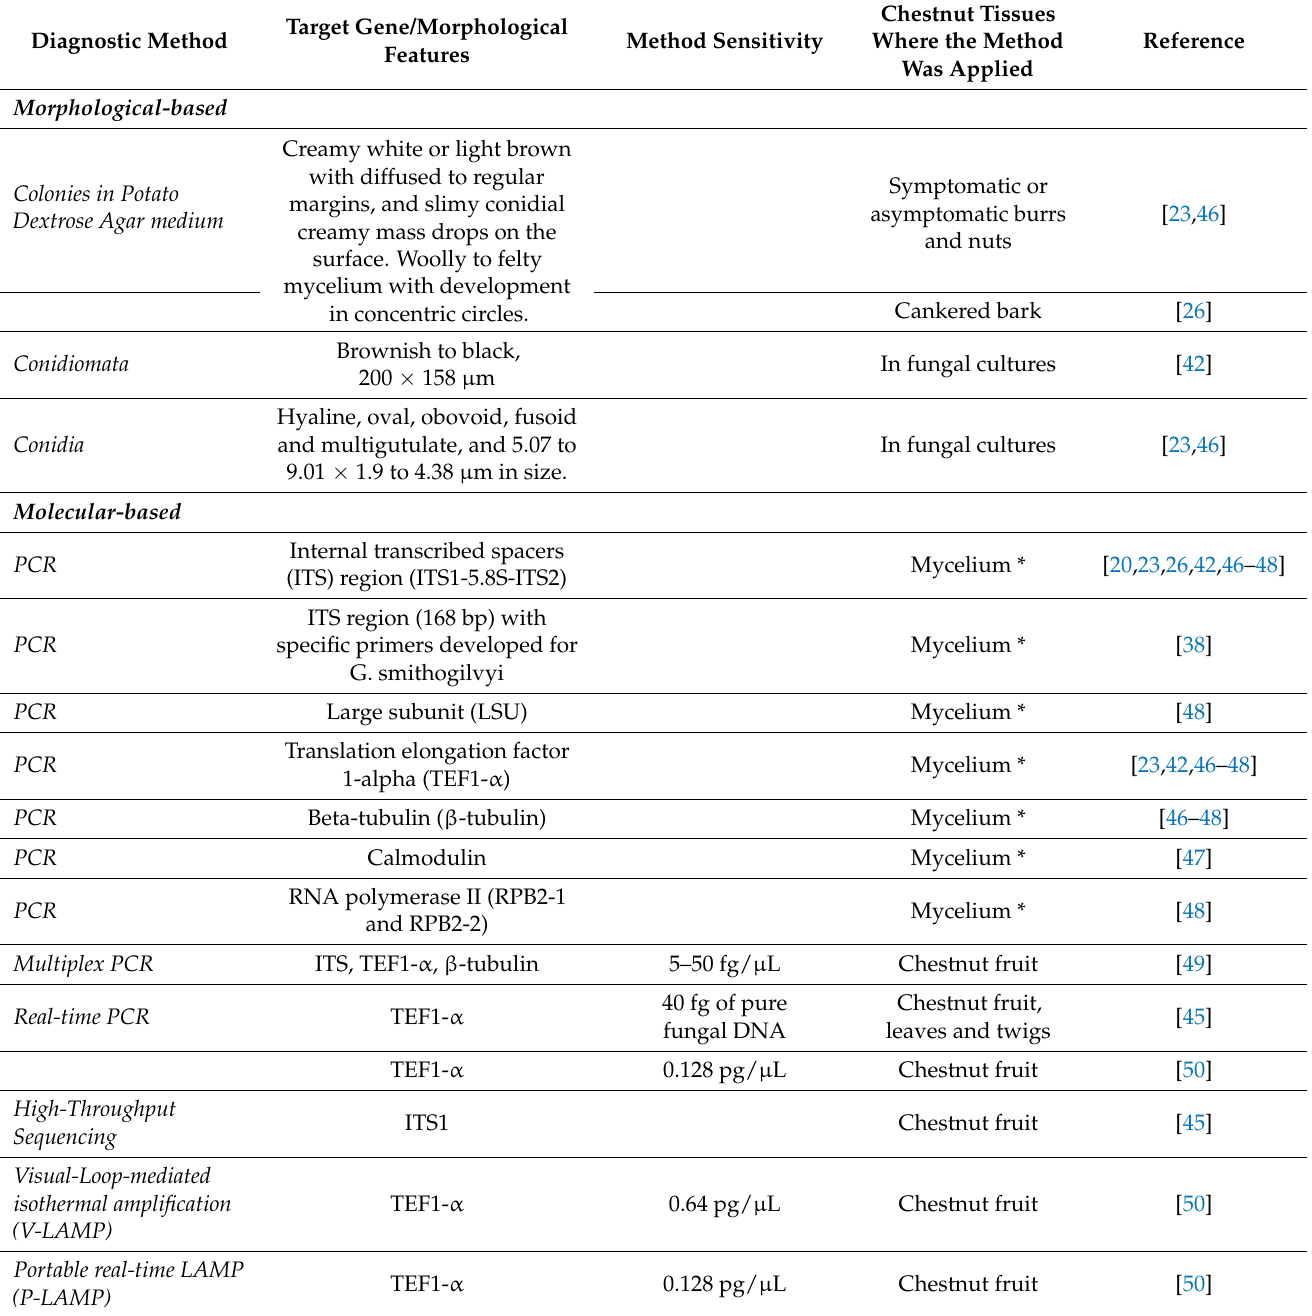
Table 1. Methods of diagnosis of G. smithogilvyi in European chestnut ( Castanea sativa